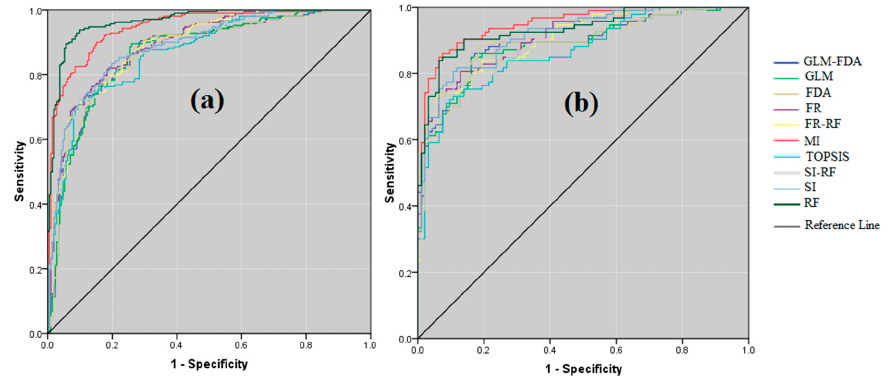
Figure 8. Area under curve in individual and ensemble models. ( a ) training data (success rate curve), ( b ) validation data (prediction rate curve).